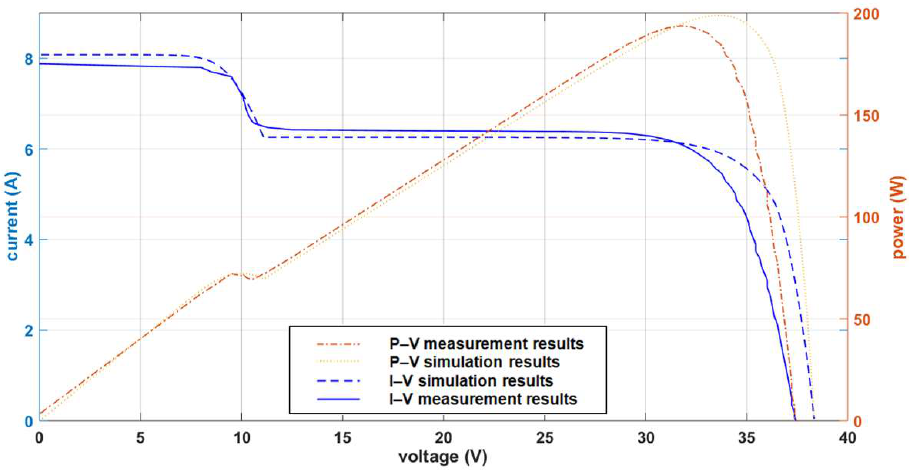
Figure 6. Verification results for measuring point P3 (see Table 2).